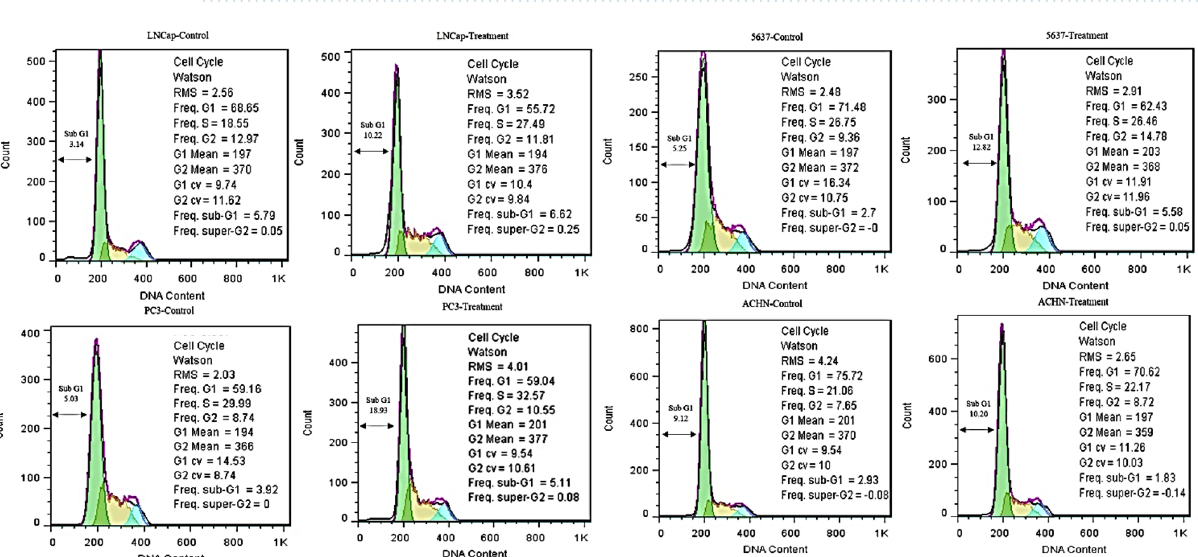
Figure 6. Cell cycle analysis of LNCaP, PC3, 5637, and ACHN cancer cell lines. DNA content of LNCaP, PC3, 5637, and ACHN cancer cell lines was assessed after exposed with exosomes by PI staining. The cell cycle analysis detected G1 area increased in LNCaP, PC3, 5637, and ACHN cell lines when treated with exosomes. The percentages of cells at the G2 phase were concurrently reduced in all treated cells. Therefore, exosomes apparently induce sub G1/G1 arrest in LNCaP, PC3, 5637, and ACHN cell